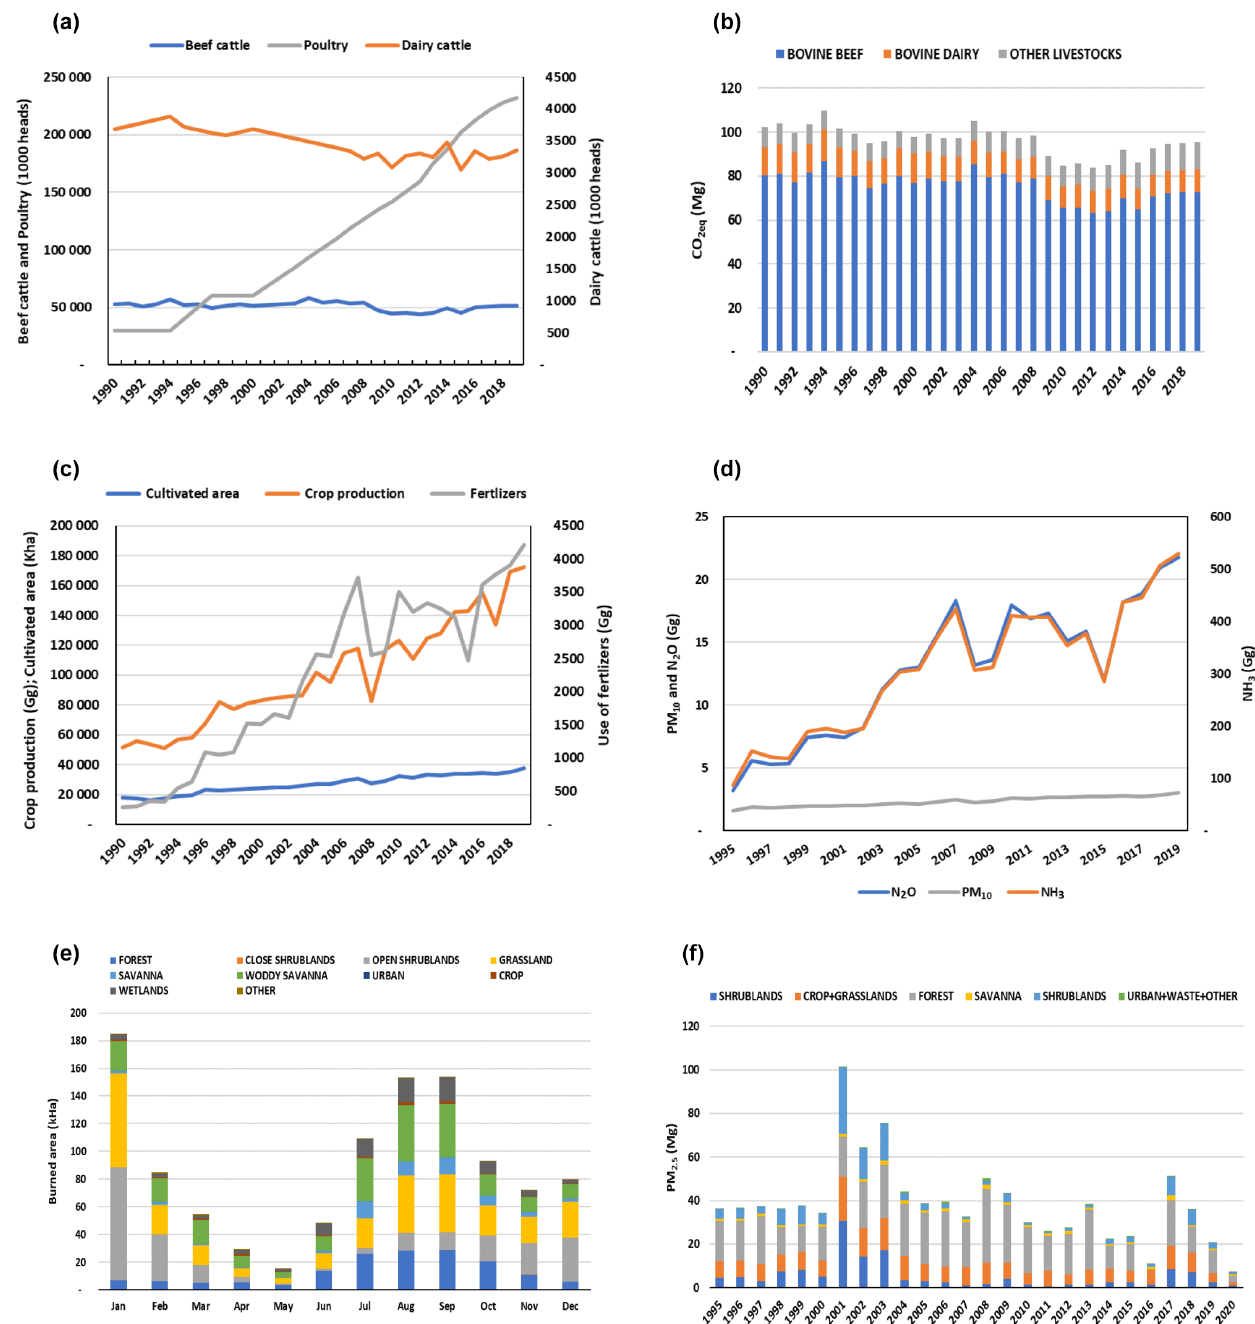
Figure 4. (a) Annual animal production for three types of livestock: beef cattle, dairy cattle, and poultry; (b) Annual evolution of GHG (in gigagrams) from for three types: bovine (beef production), bovine (dairy production), other livestock breeds. (c) Annual evolution of main agriculture indices: crop production (Gg), cultivated area (kHa), and use of fertilizers (Gg). (d) Annual emissions of N 2 O, NH 3 , and PM 10 from fertilizer use and arable lands. (e) Average station burned area in kilohectares for the period 1995–2020, according to land type. (f) Annual emissions evolution of PM 2 . 5 (kt) for the period 1995–2020, according to land type.